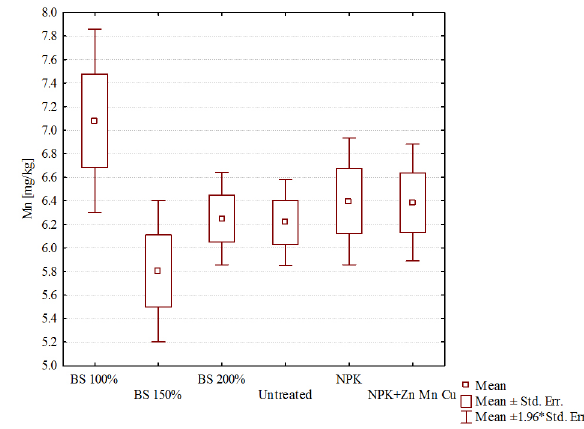
Figure 5: Manganese content [mg kg -1 ] in grain vs. fertilizer.